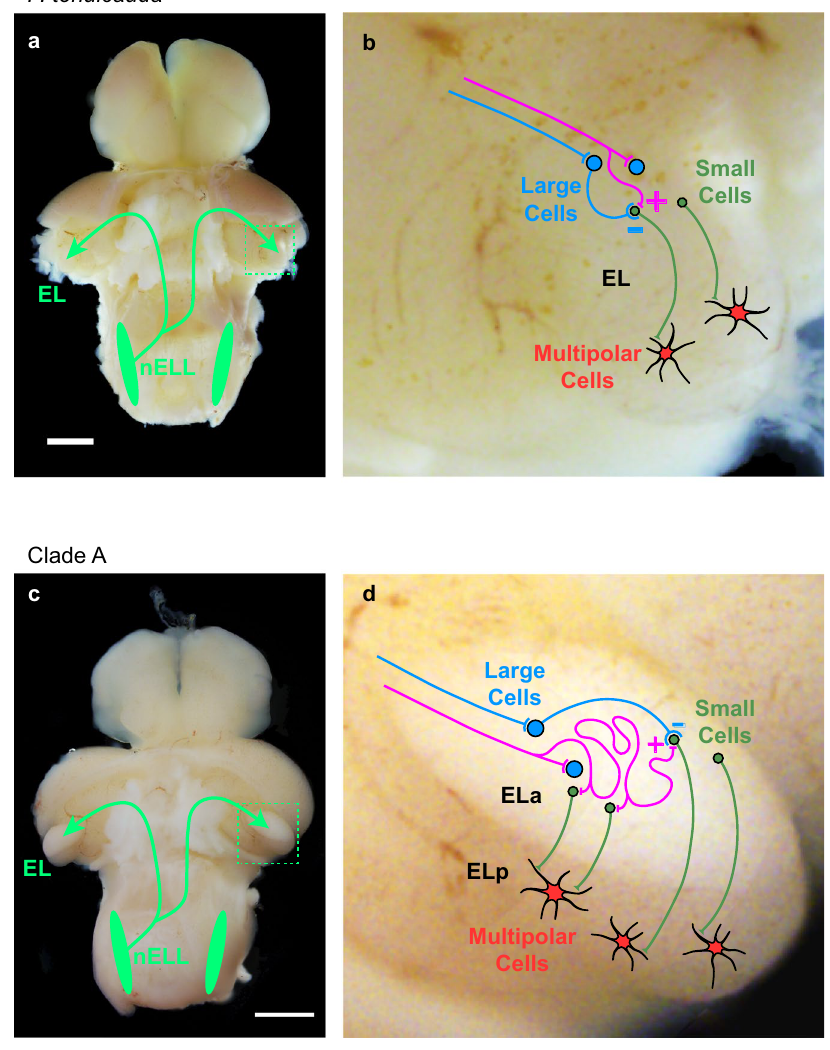
Figure 8. Schematic of the knollenorgan electrosensory pathway of species with small and undifferentiated EL and species with enlarged and subdivided ELa/ELp. ( a ) Photograph of the brain of P . tenuicauda ( a ) and B . niger ( c ) with the valvula cerebellum removed to expose the hindbrain and midbrain. Neurons in the electrosensory lateral line lobe (nELL) in the hindbrain project bilaterally to the exterolateral nucleus of the midbrain (EL). In clade-A species and P . microphthalmus , EL is enlarged and subdivided into anterior (ELa) and posterior regions (ELp). Enlarged photograph of EL ( b ) and ELa/ELp ( d ) with a schematic of the neural circuits. In species with a small and undifferentiated EL ( b ), axons of nELL cells synapse onto two types of cells in the lateral lemniscus and the anterior end of EL: GABAergic cells (large cells) and adendritic small cells. Large cells project onto small cells, establishing an excitatory-inhibitory circuit by which small cells in EL likely perform signal location analysis based on a subtraction mechanism. Small cells project to multipolar cells in the posterior end of EL that perform inter-pulse interval analysis. In species with ELa/ELp ( d ) nELL axons synapse onto GABAergic cells (large cells) upon entering ELa and then follow a long and convoluted path, synapsing on several adendritic small cells throughout their length. Inhibitory large cells project onto small cells, establishing a delay-line anti- coincidence detection mechanism by which small cells in ELa perform EOD waveform analysis. Small cells in ELa project to multipolar cells in ELp that perform inter-pulse interval analysis. Scale bars = 1